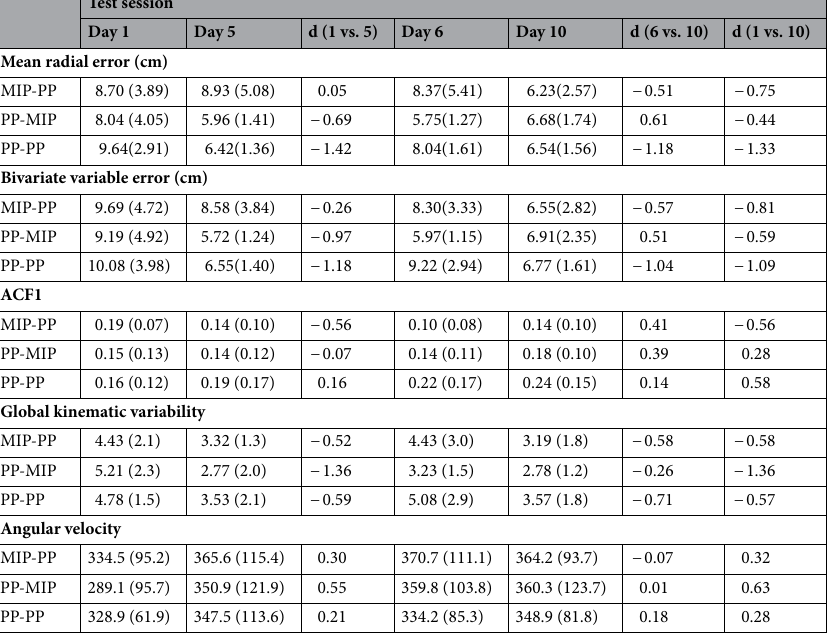
Table 1. Behavioural data (mean and SD) for task-related performance outcomes (mean radial error; RE, and bivariate variable error; BVE), and autocorrelation lag-1 (ACF1) calculation. Effect sizes characterising changes in performance (day 1 minus day 5; day 6 minus day 10; and day 1 minus day 10) are included. Improvements in performance are noted by negative effect sizes reflecting a decrease in error (mean RE and BVE) and global kinematic variability, and positive effect sizes reflecting an increase in trial-by-trial correction factor (ACF1) and angular velocity. Data for test sessions on day 1 and 5 is previously reported in Kraeutner et al. 40